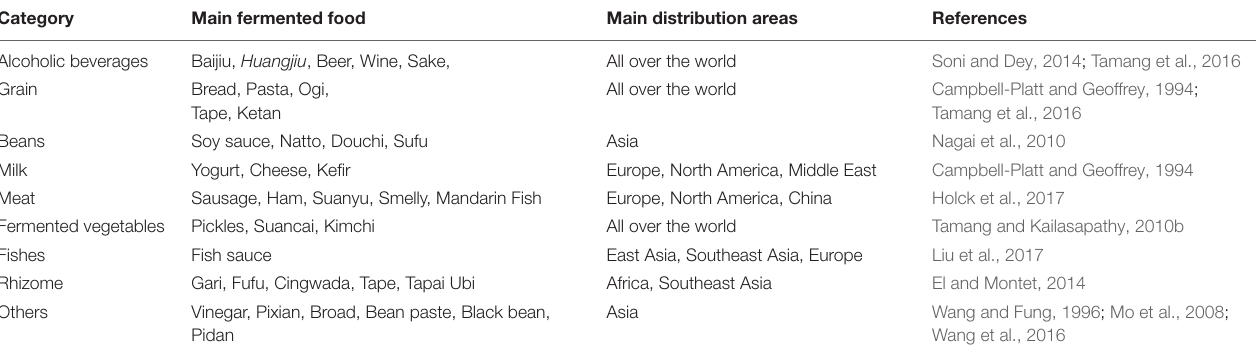
TABLE 1 | Main classification of fermented food in the